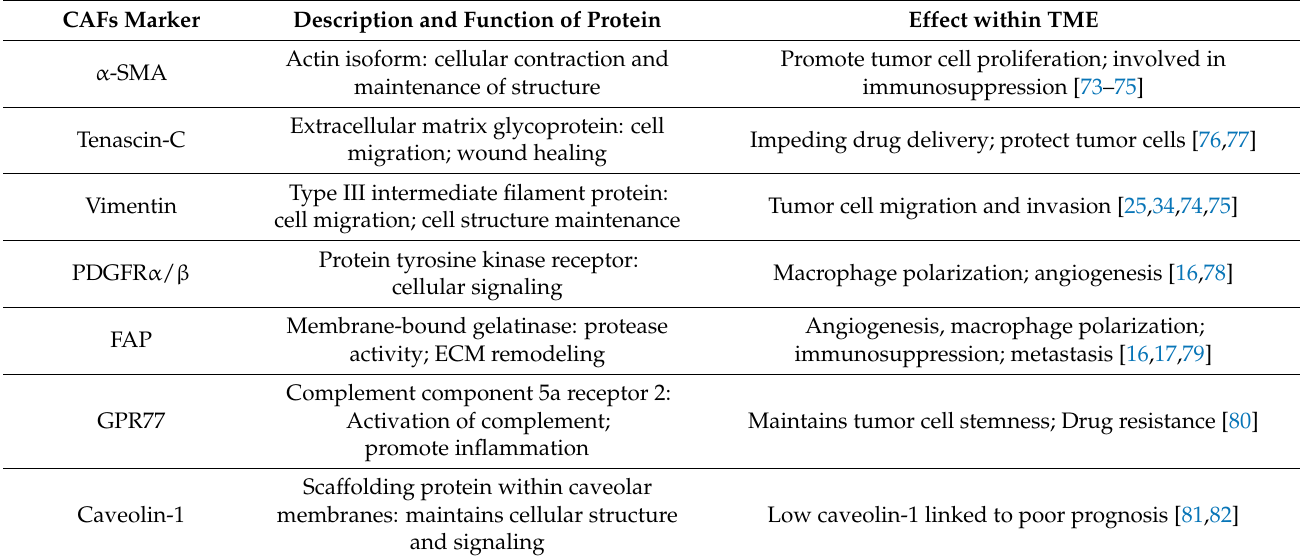
Table 1. Markers for cancer-associated